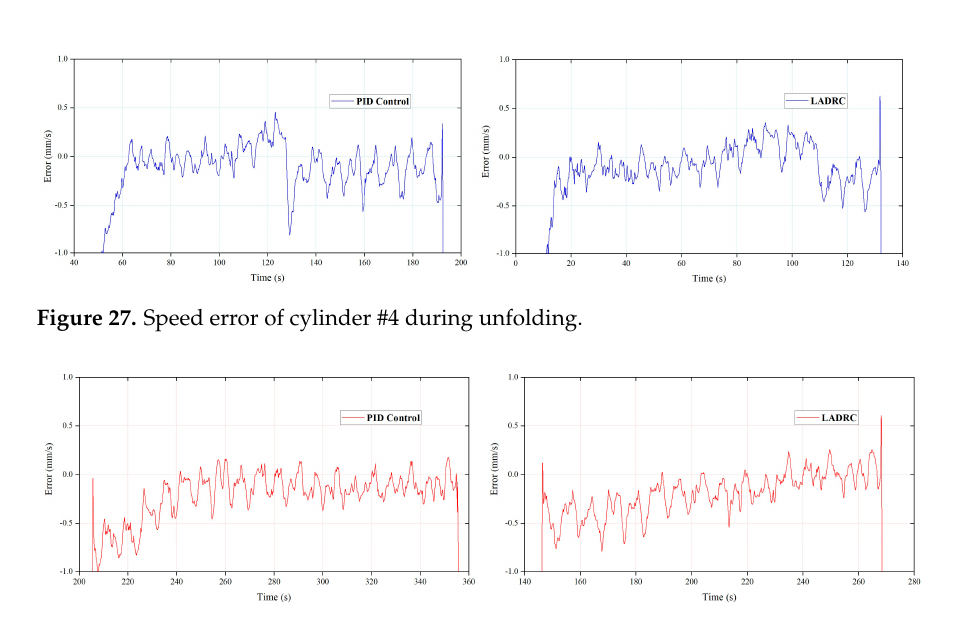
Figure 26. Step response experiment results of cylinder #4 using FLADRC.